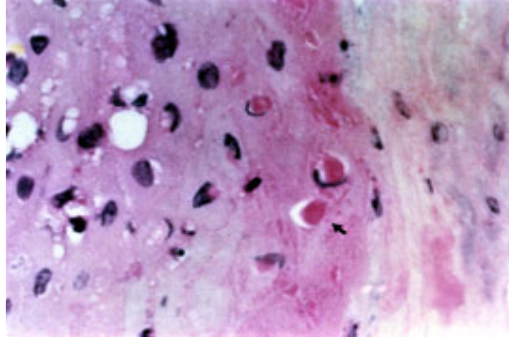
Figure 8: Histological alterations characteristic of this disease.